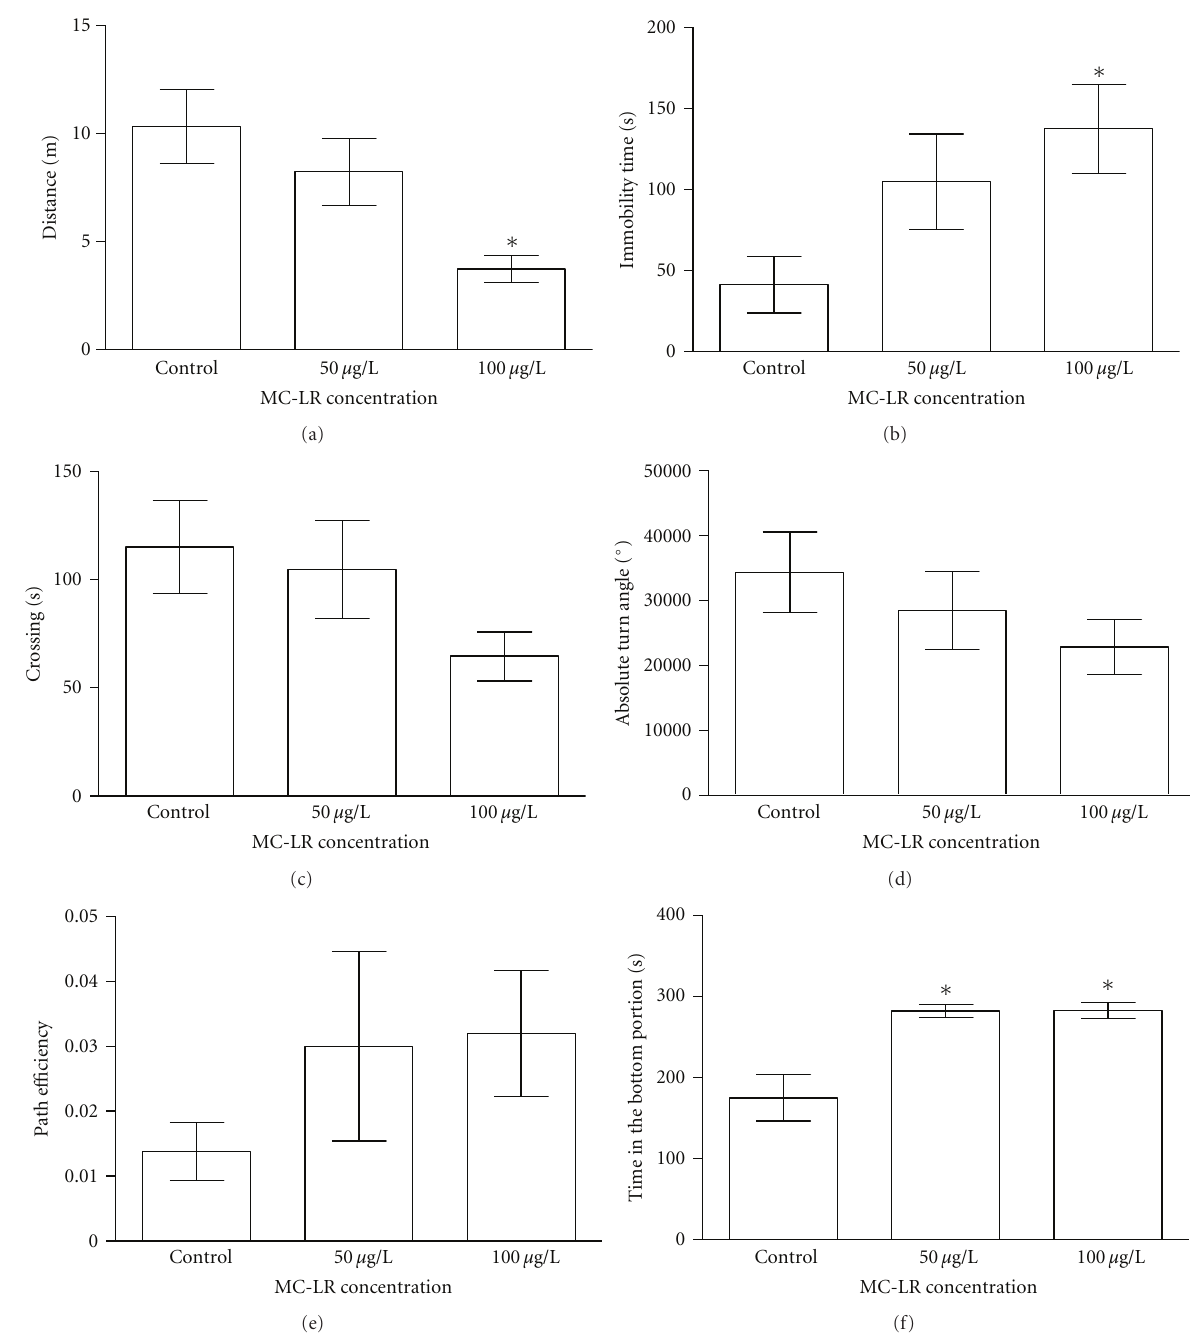
Figure 1: E ff ect of microcystin-LR exposure on the distance traveled (a), immobility time (b), number of line crossings (c), absolute turn angle (d), path e ffi ciency (e), and time in the bottom portion (f) determined during 5min of video recording in the tank-diving behavioral test. Data expressed as mean ± SEM. n = 10. One-way ANOVA/Newman-Keuls post hoc test. ∗ : P < 0 . 05 compared to control